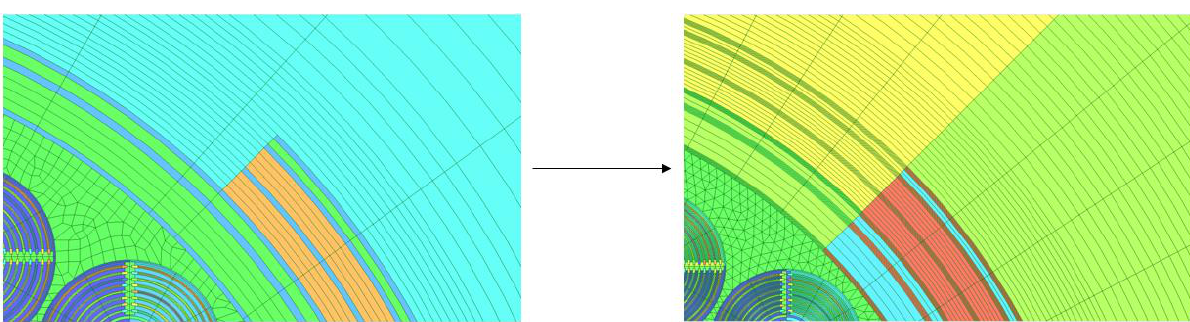
Figure 5. Comparison between the former and the new spatial mesh for the MOC2D core calculation.